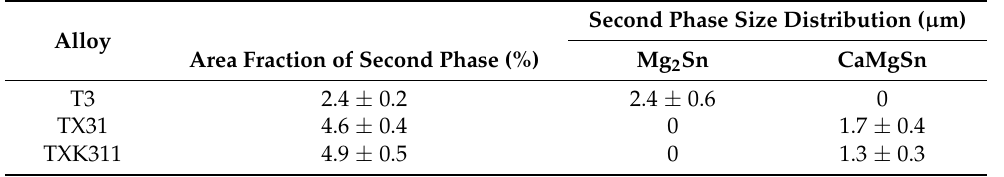
Figure 4. SEM of as-extruded alloys: ( a , b ) T3, ( c , d ) TX31, ( e , f ) TXK311. ( ED : Extrusion direction, TD : Transverse direction). Table 2. Area fraction and size distribution of the second